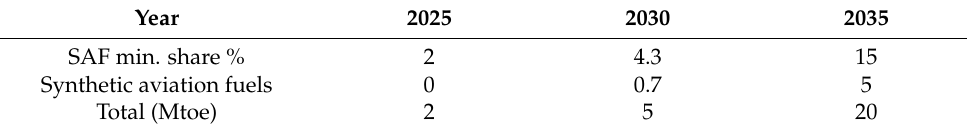
Table 1. Proposed mandates as per the ReFuelEU aviation